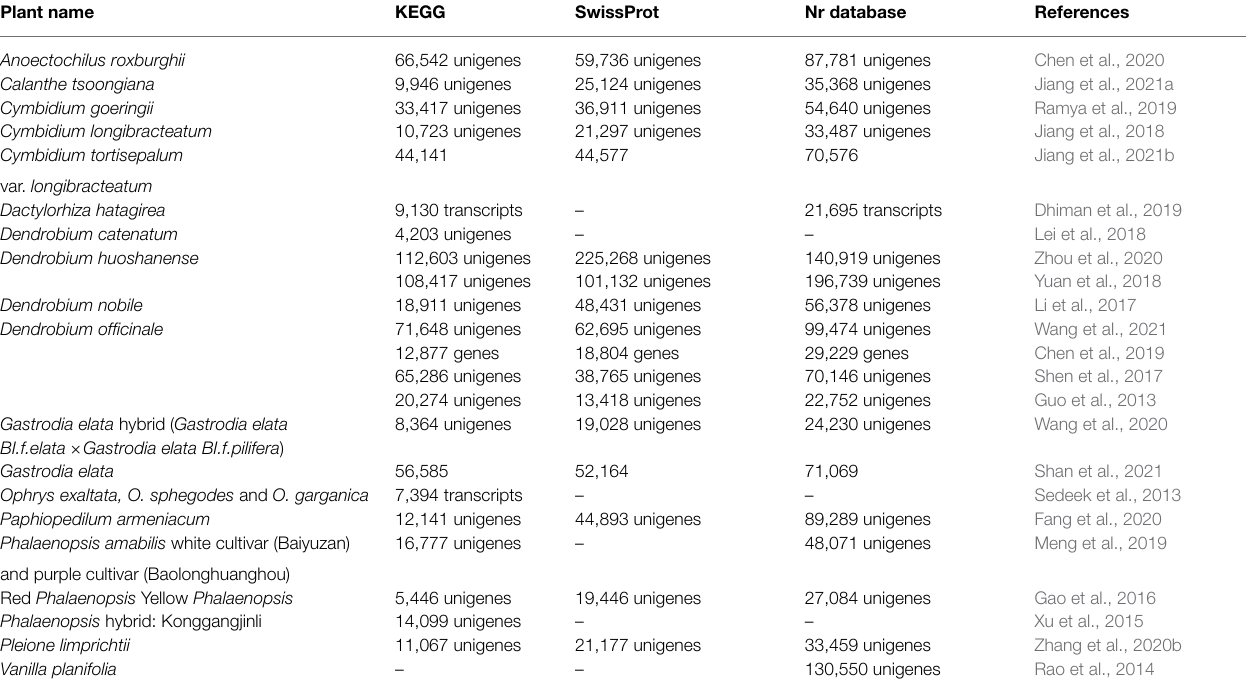
TABLE 2 | Functional Annotation using KEGG, SwissProt, and non-redundant (Nr)